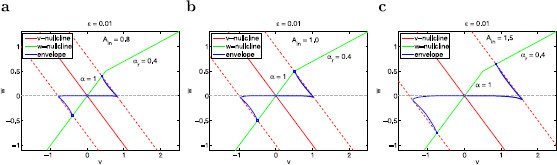
Voltage response of the PWL system (37)–(38) with hv and hw given by (40) to sinusoidal inputs. a Ain=0.8. bAin=1. cAin=1.5. We used the following parameters: α=1, η=−1, αr=0.4, vc=0.5, ϵ=0.01